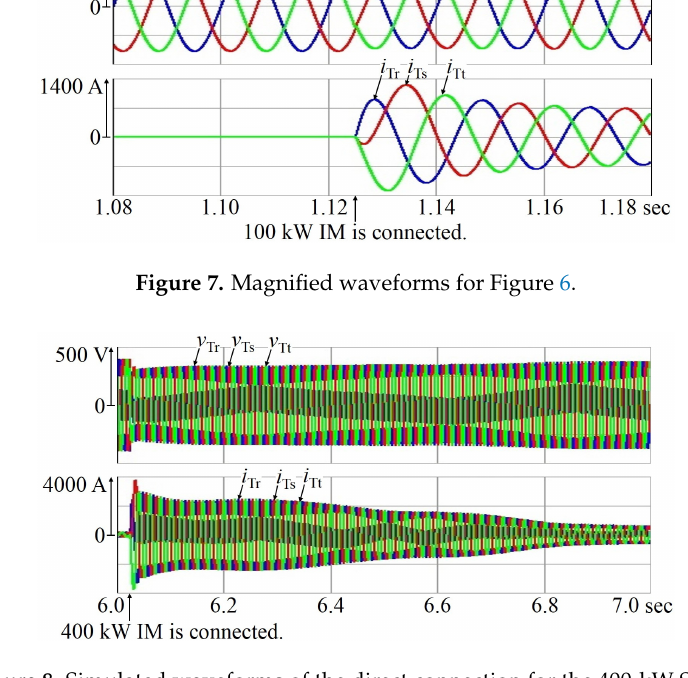
Figure 8. Simulated waveforms of the direct connection for the 400-kW